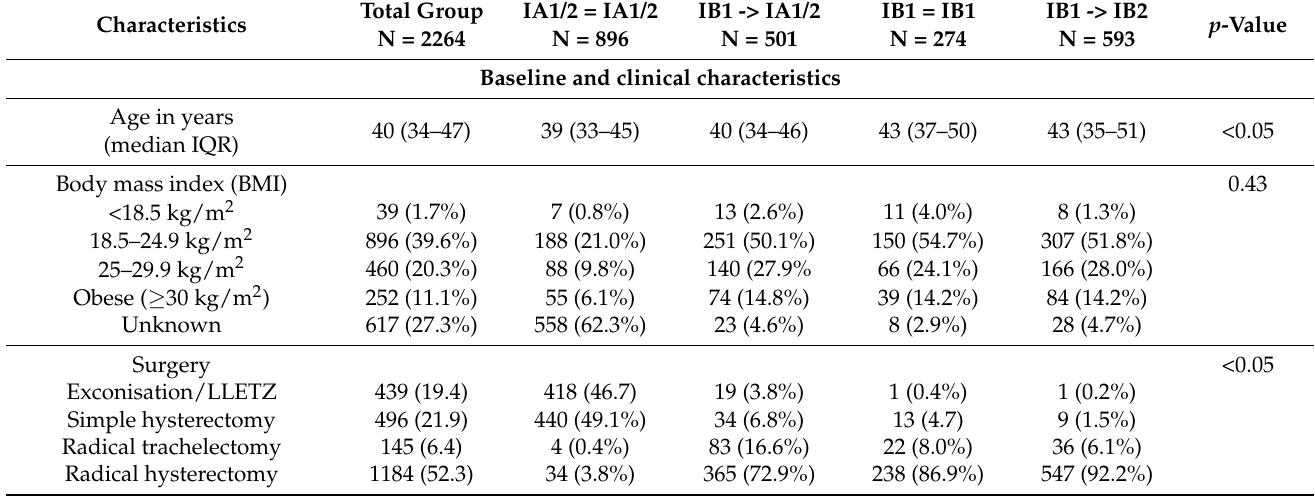
Table 2. Baseline-, clinical- and histopathology characteristics of study population and stage migra- tion groups.